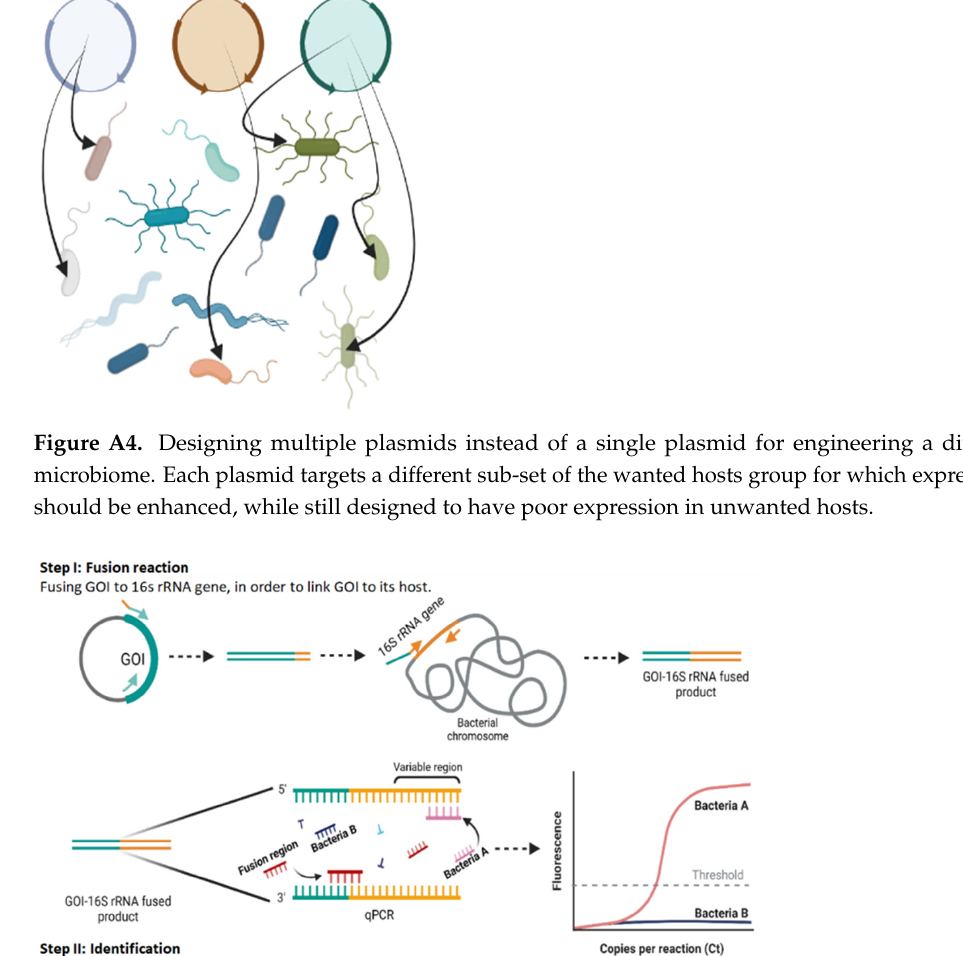
Figure A7. Integration of the algorithm in order to optimize the dairy production process. Genes that can improve the dairy production process (in terms of speed, quality, etc.) are inserted to the participating bacteria, thus optimizing the process. References 1.